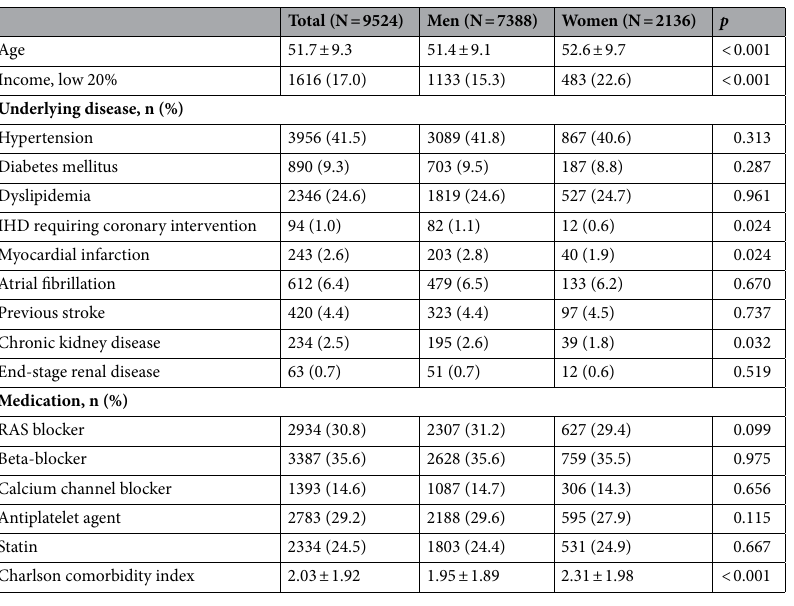
Table 1. Baseline characteristics in the original cohort of patients with HCM. HCM hypertrophic cardiomyopathy, IHD ischemic heart disease, RAS renin–angiotensin